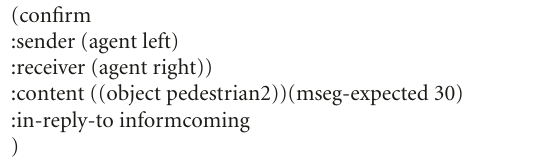
And the right agent is executing just one tracking plan for pedestrian2 and a surveillance plan. It has also these initial beliefs: “close-agent (left, overlap0)” and “location- pedestrian (pedestrian2,